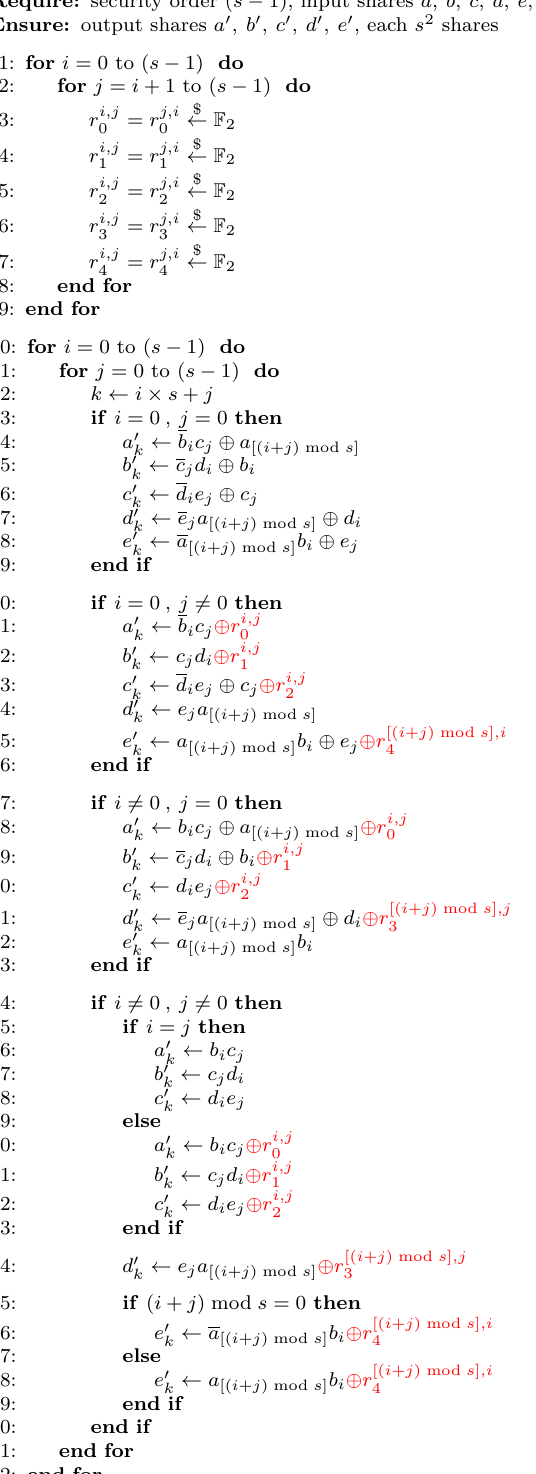
Algorithm 2 Generating composable output shares in χ function for the low-latency